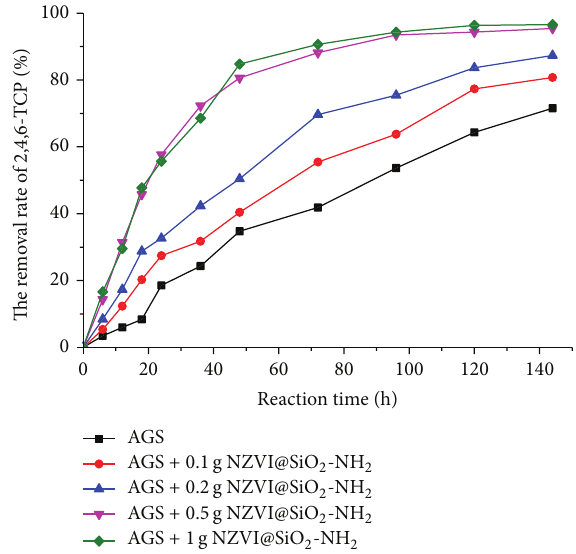
Figure 9: The degradation curves of 2,4,6-TCP by the anaerobic treatment process ( 𝑇 = 35 ± 0.1 ∘ C, pH = 7.0, initial concentration of 2,4,6-TCP ( 𝐶 0 ) = 50mg/L, anaerobic granular sludge = 10g VSS, and stirring rate = 150 rpm).